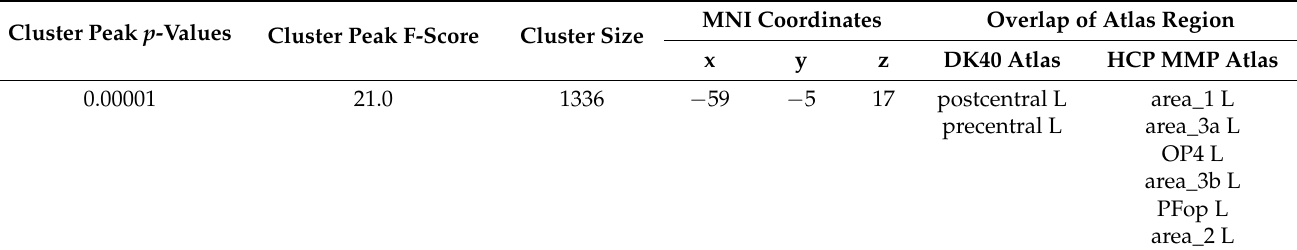
Note: The peak p -value, peak F-score and MNI (Montreal Neurological Institute) coordinates (x, y, z) of the peak vertex are reported. The DK40 atlas and HCP MMP atlas are used to report the brain regions with significantly different cortex thickness. The postfix “L” means the cluster located in left